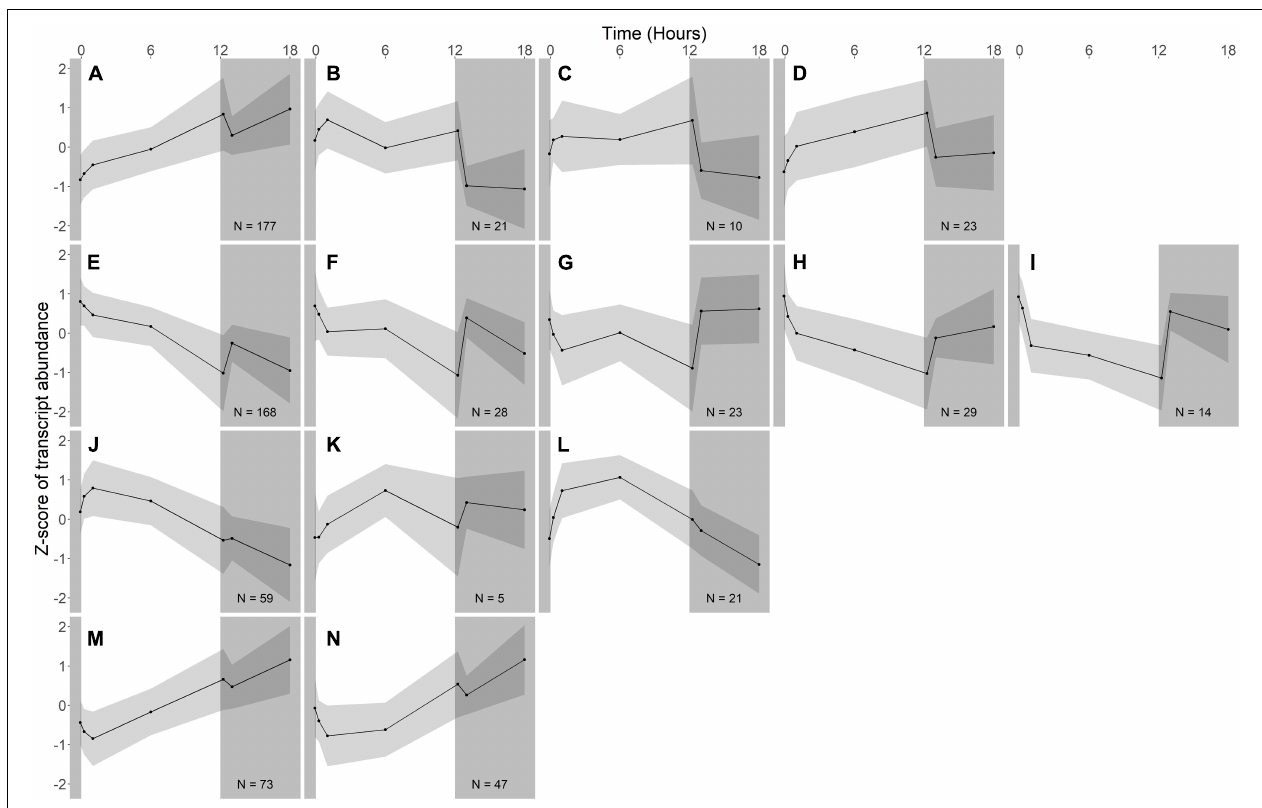
FIGURE 4 | Gene expression groups in A. photophilum strain MWH-Mo1. Groups of genes with similar expression patterns were identified using hierarchical clustering. Means of the z-scores for all genes are plotted, with one standard deviation indicated by the gray shading. N indicates number of genes in each group. In this species, most genes respond more strongly to darkness than to light. (A–D) Groups of genes whose expression increases in the light and rapidly decreases in the dark. (E–I) Groups of genes whose expression decreases in the light and rapidly increases in the dark. (J–L) Groups of genes whose expression increases early during the light period, then decreases. (M,N) Groups of genes whose expression decreases early during the light period, then